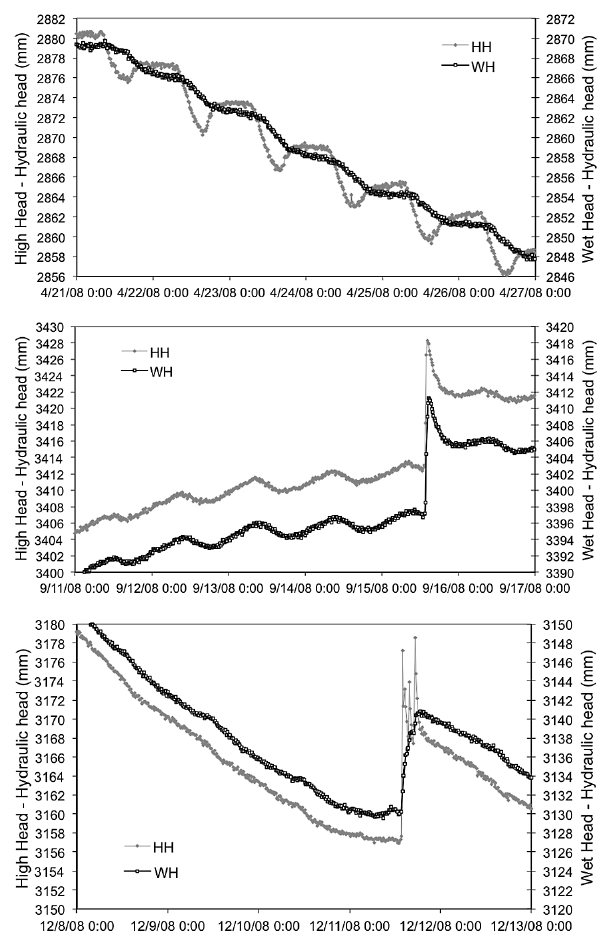
Fig. 4. (a) Early dry season (21–27 April 2008) hydraulic